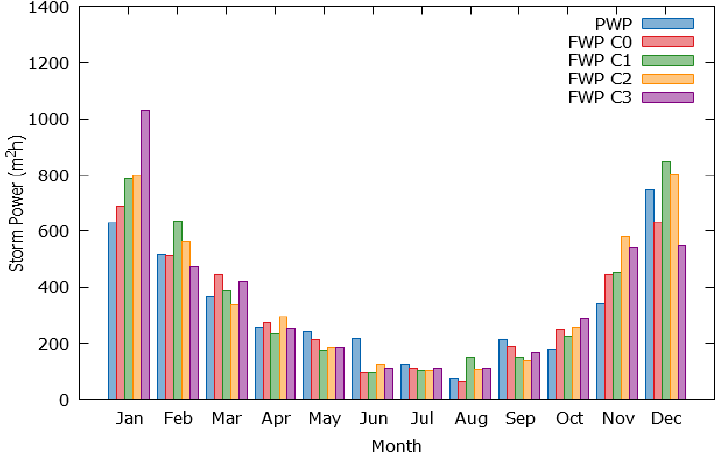
Figure 13. Comparison of present (PWP) and future (FWP-C0–C3) storm power index ( 𝑆 𝑝𝑖 ) at West Gabbard.